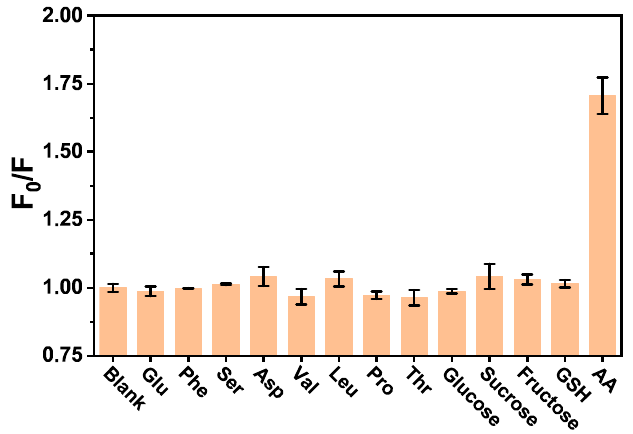
Figure 3. Selectivity of the fluorescence sensor for AA detection.